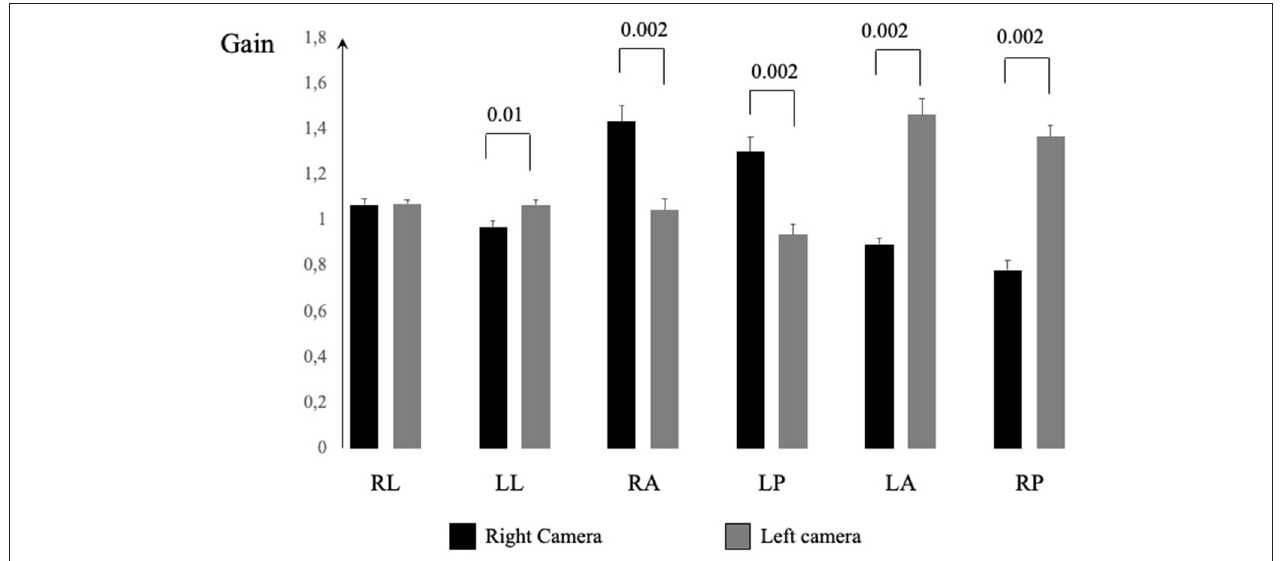
FIGURE 3 | The average and SEM gain values from each canal and recording device positioned over the left or right